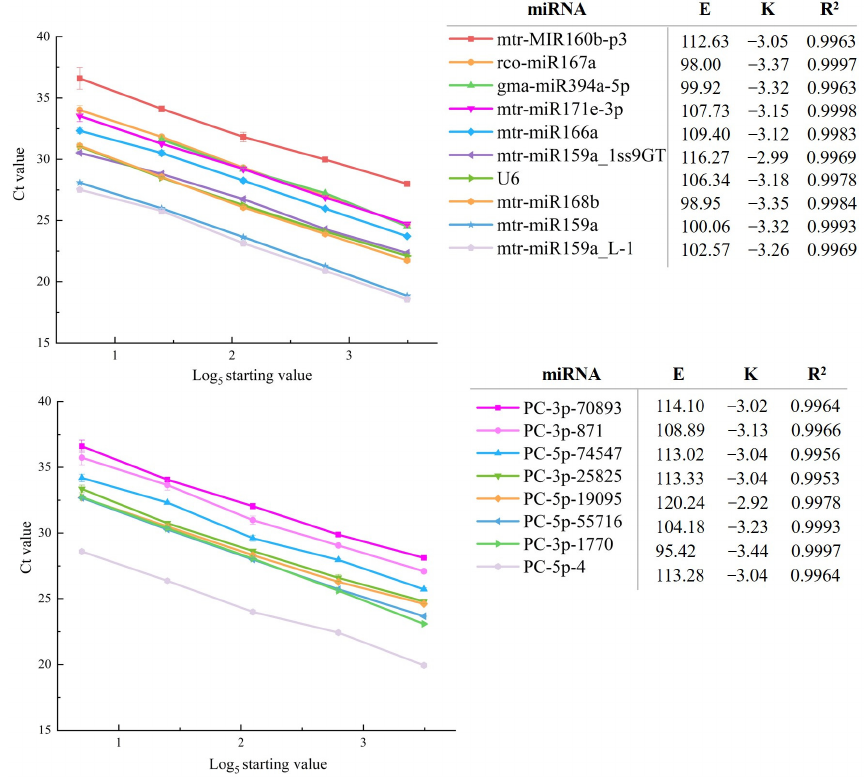
Figure 4. Amplification efficiency curves.